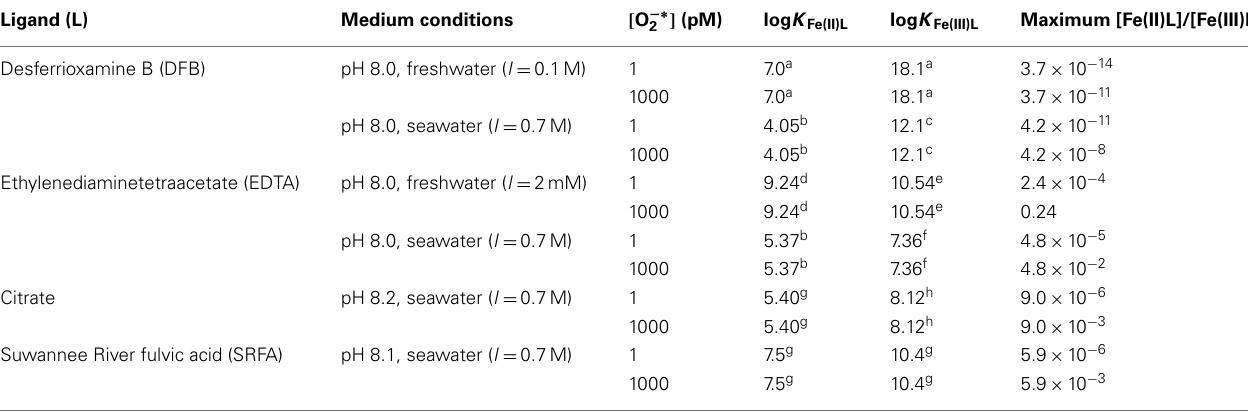
Table 1 | Calculated ratios of [Fe(II)L]/[Fe(III)L] below which reduction of Fe(III)L to Fe(II)L by O −∗ complexes in natural waters around pH